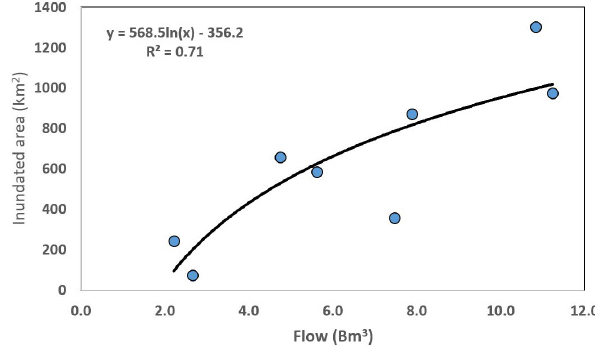
Figure 5. Relationship between annual maximum flood inundated area and the maximum monthly river flow in